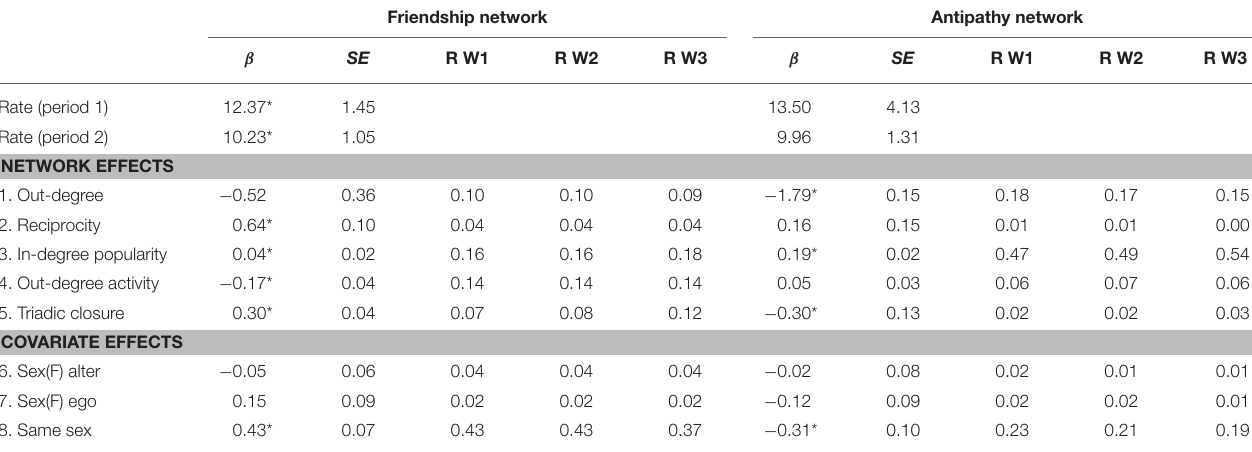
TABLE 4 | Univariate models: parameter estimates ( β ), standard errors ( SE ), and expected relevance importance for each wave (R